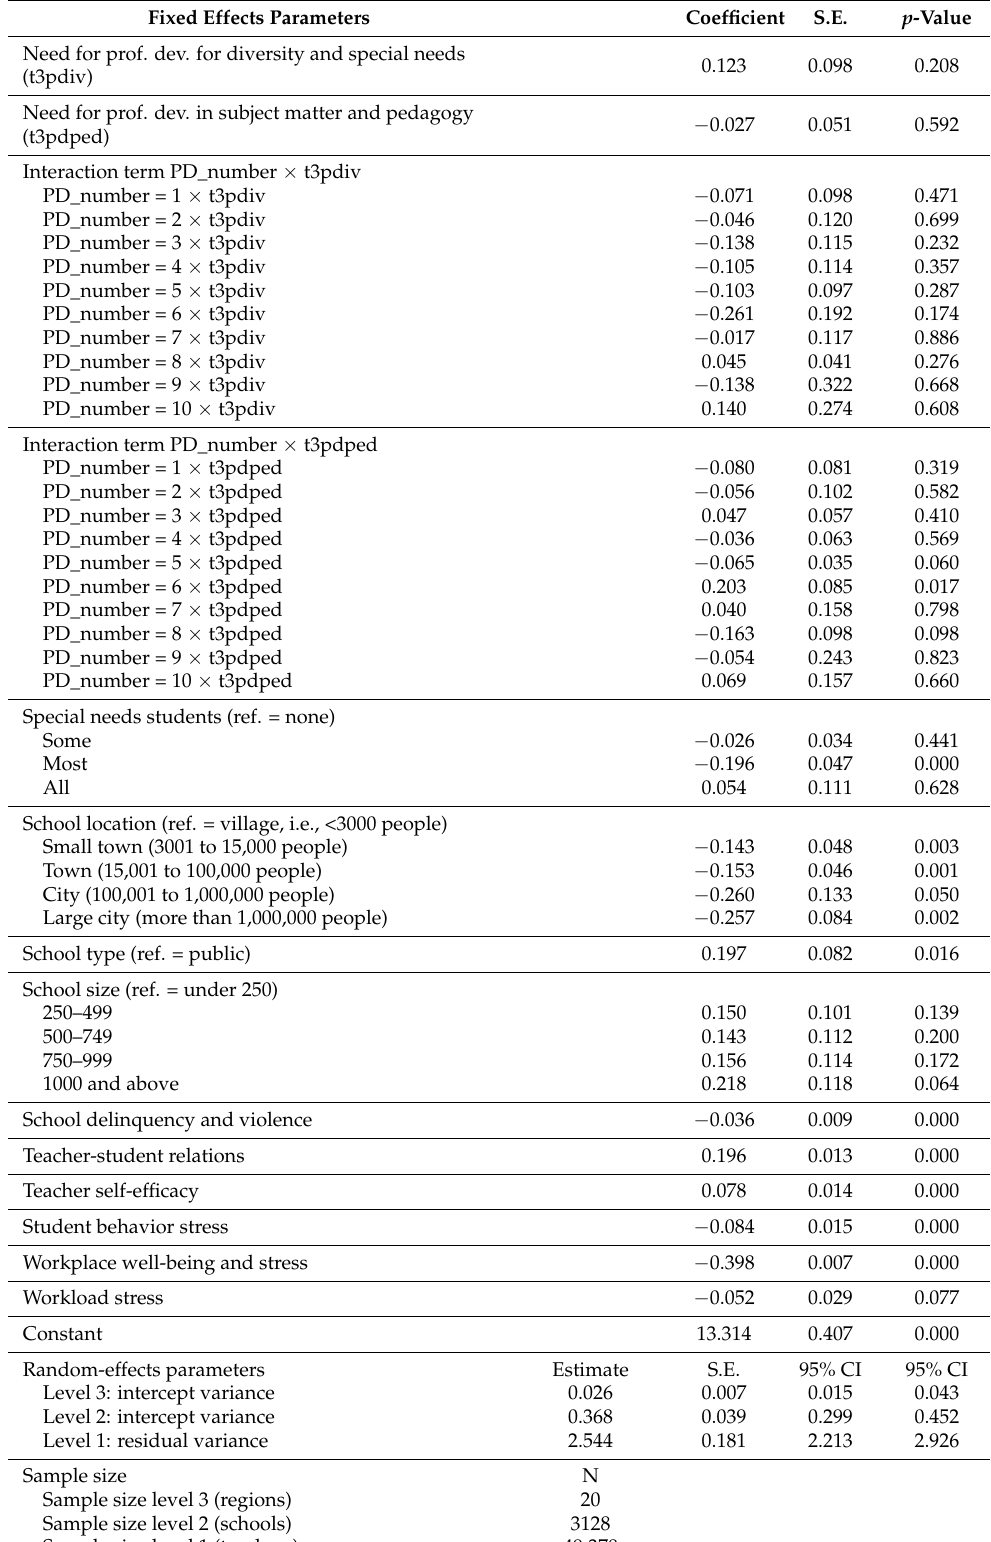
Table A1. Cont . Fixed Effects